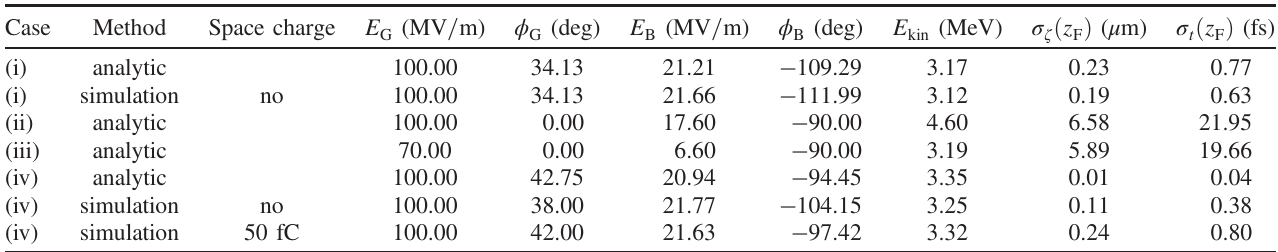
TABLE I. Overview of the parameter settings for the different bunching configurations discussed.